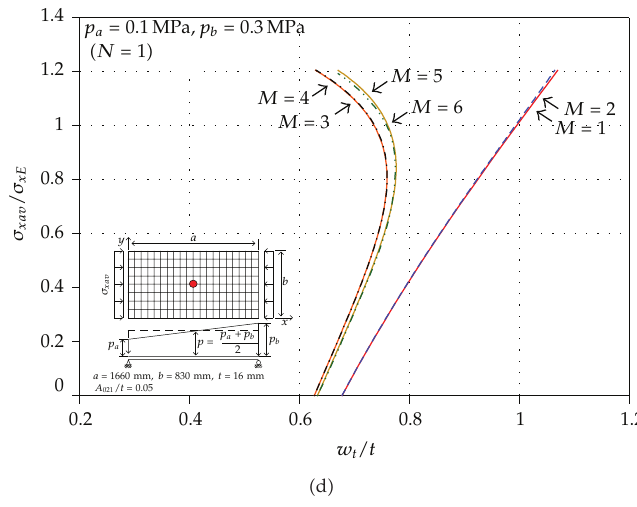
Figure 5: (cid:8) a (cid:9) The axial compressive load versus total deflection curves at p a (cid:6) p b (cid:6) 0 . 1MPa. (cid:8) b (cid:9) The axial compressive load versus total deflection curves at p a (cid:6) 0 . 1MPa and p b (cid:6) 0 . 15MPa. (cid:8) c (cid:9) The axial compressive load versus total deflection curves at p a (cid:6) 0 . 1MPa and p b (cid:6) 0 . 2MPa. (cid:8) d (cid:9) The axial compressive load versus total deflection curves at p a (cid:6) 0 . 1MPa and p b (cid:6) 0 .